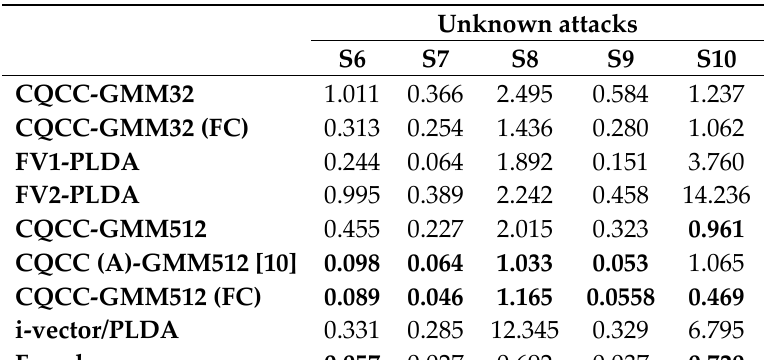
Table 5. Spoofing detection performance (in terms of EER) of all systems considered herein, including the Fisher vectors-based systems on the ASVspoof2015 evaluation set. Scores are evaluated against each spoofing attack (S1–S10) and results are reported on each of the unknown attacks. The lowest EERs are highlighted in bold